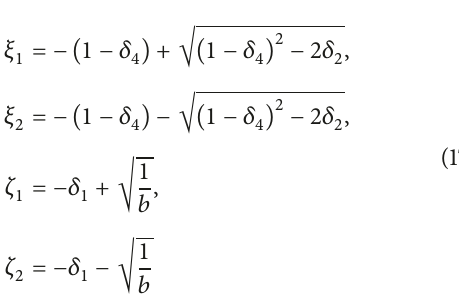
Figure 4: Extreme multistability demonstrated by attraction basins in two different planes. (a) Attraction basin in the x 2 (0)- x 4 (0) plane with x 1 (0) = 0 and x 3 (0) = 0.2. (b) Attraction basin in the x 3 (0)- x 4 (0) plane with x 1 (0) = 0 and x 2 (0) = 0.1.